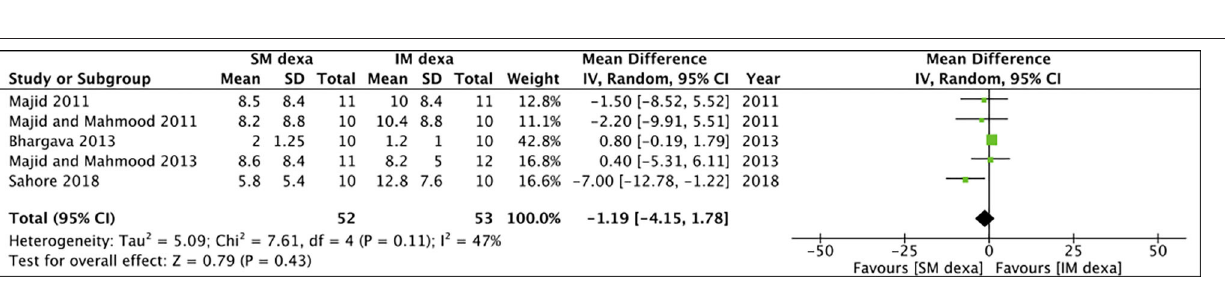
FIGURE 12 | Meta-analysis of early trismus between SM and IM dexamethasone (dexa) for third molar surgeries.